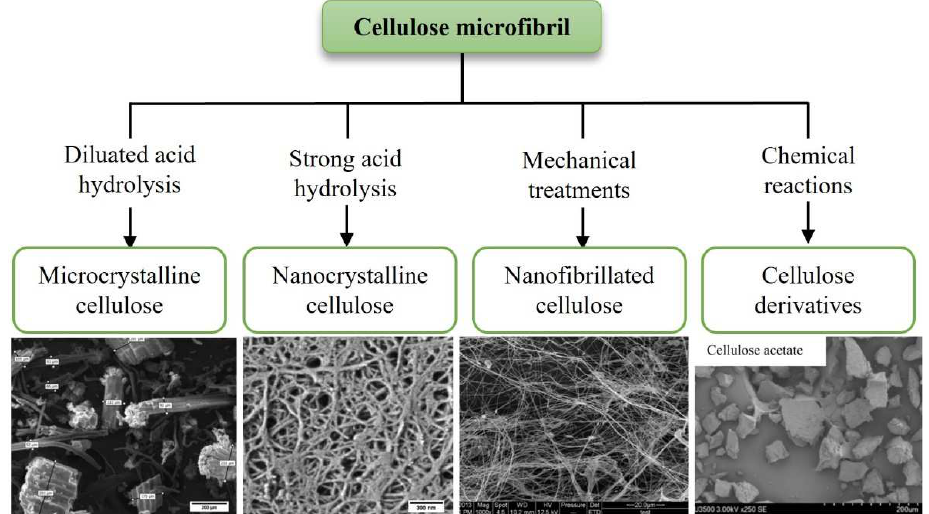
Figure 4. Examples of different cellulose types, according to different preparation methods. Surface electron microscopy images illustrating different microstructures; these were reproduced with permission. [31–33]. (Copyright 2016, 2020, 2022, Elsevier.) When cellulose undergoes diluted acid hydrolysis, MCC is originated, and rod-like particles are formed at a microscale diameter and length. The obtained MCC shows high crystallinity since the amorphous regions of the cellulose chain are partially removed dur- ing this type of treatment [34]. On the other hand, from strong acid hydrolysis, NCC is obtained, while from mechanical treatments, such as high-pressure homogenization or the application of high-intensity ultrasounds, NFC is generated. These two types of cellu- lose are classified as a nano-cellulose because of their nanoscale dimensions [35]. The cellulose derivatives include various esters and ethers, such as cellulose acetate (CA), cellulose nitrate (CN), cellulose sulfate (CS), ethyl cellulose (EC), methylcellulose (MC), carboxymethyl cellulose (CMC), hydroxyethyl cellulose (HEC), hydroxypropyl cel- lulose (HPC), hydroxypropyl methylcellulose (HPMC), and others (Figure 5) [27]. These will be further discussed, as we consider their importance, properties, characteristics, functionalization, and applications.